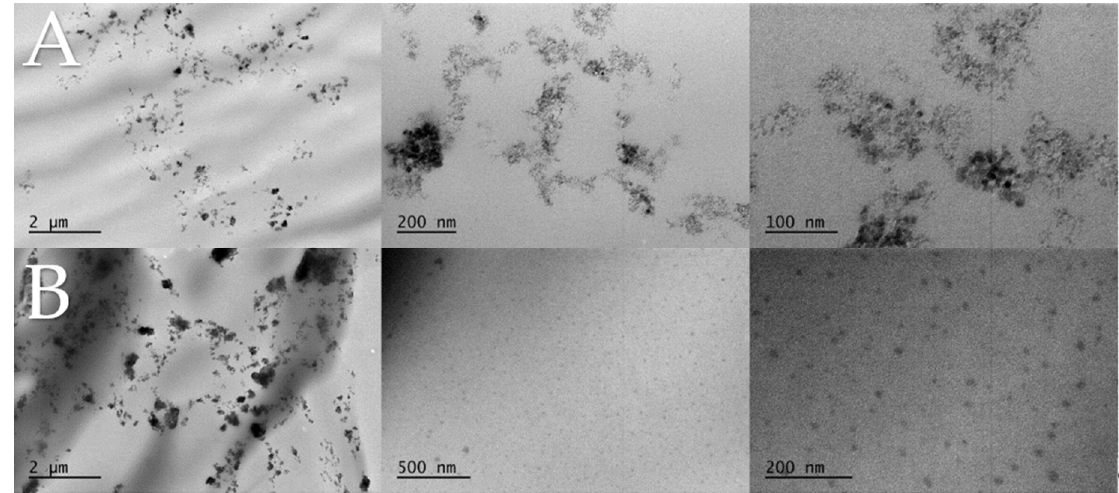
Figure 5. Transmission electron microscopy (TEM) cross-section images of films ( A ) F1/2ND and ( B ) F1/C/2ND. Magnification from left to right.